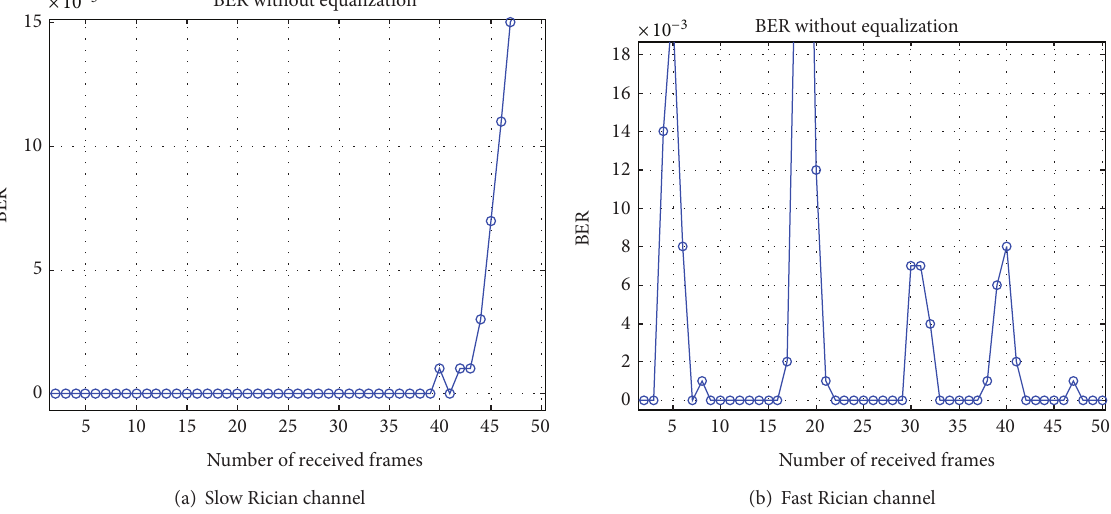
F 6: BER without equalizer in the Rician channel.